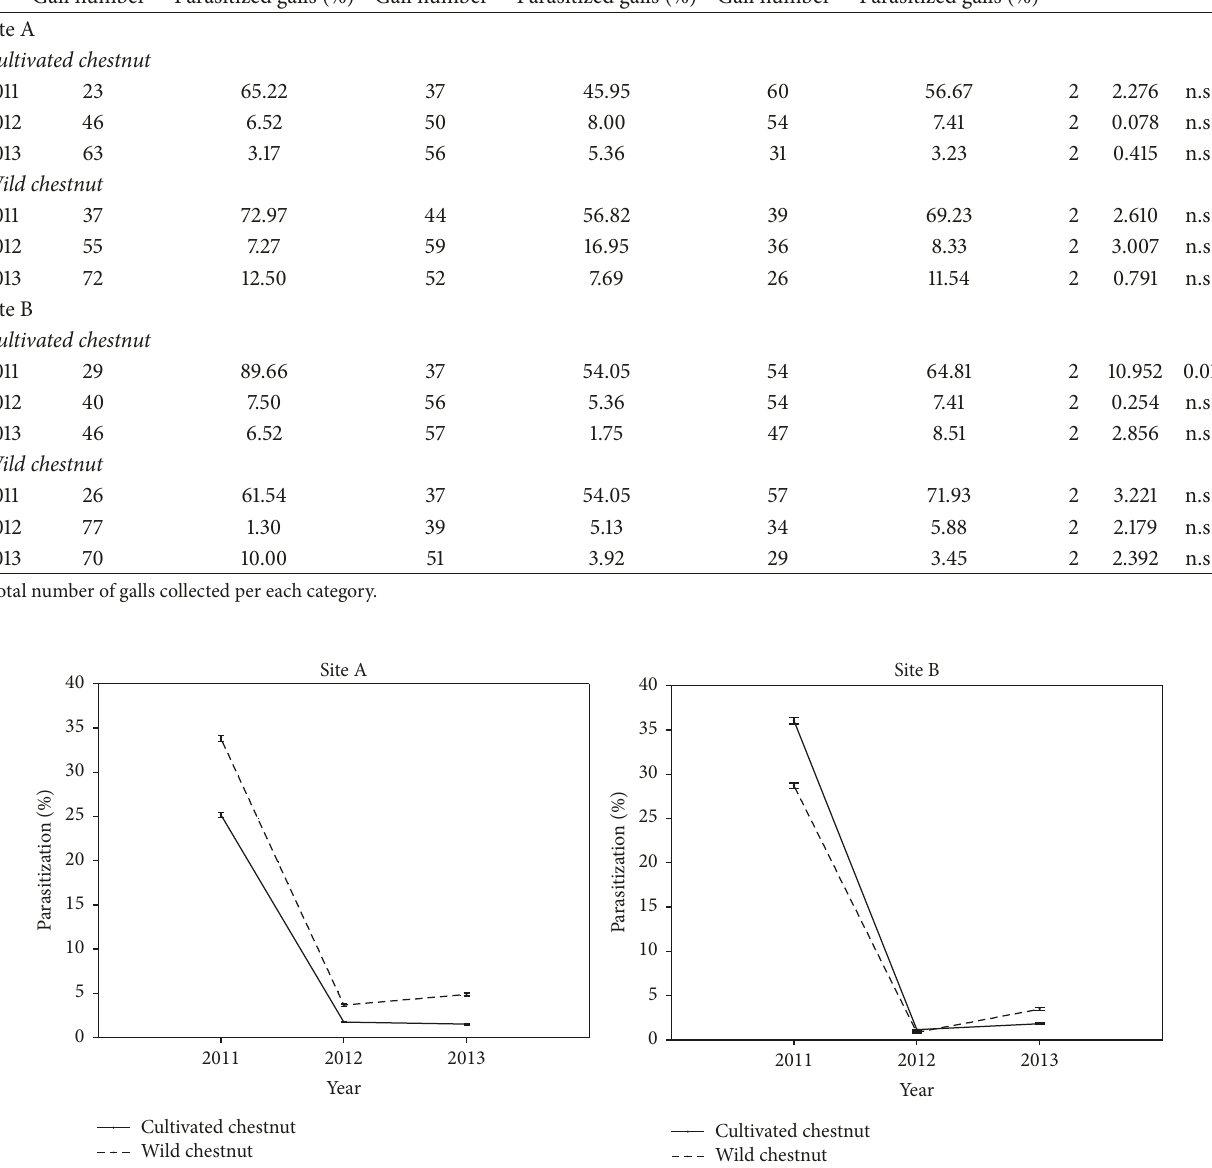
Figure 4: Mean percentage of parasitized Dryocosmus kuriphilus cells. Samples collected from cultivated and wild chestnuts in the two study sites (site A = 478 m a.s.l.; site B = 665 m a.s.l.) at Marradi (Italy) during the three-year period. Bars represent standard